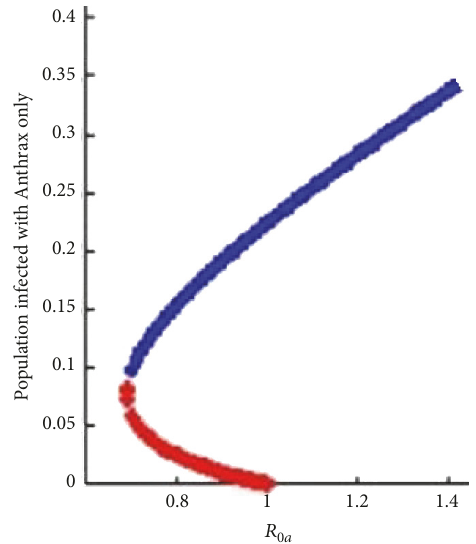
Figure2:Simulationofthecoinfectionmodelshowingtheexistence of backward